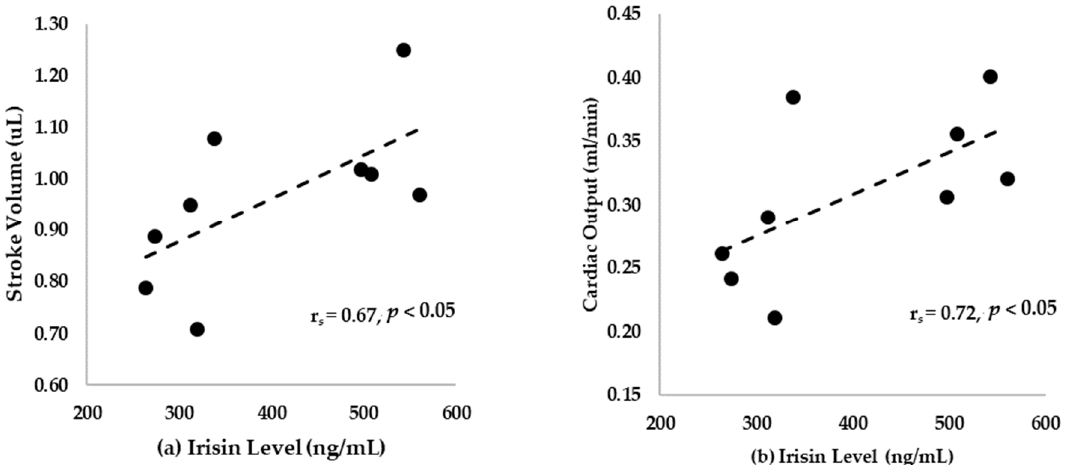
Figure 3. ( a ) The correlation between stroke volume ( μ L) and irisin level; ( b ) the correlation between cardiac output (mL/min) and irisin levels.